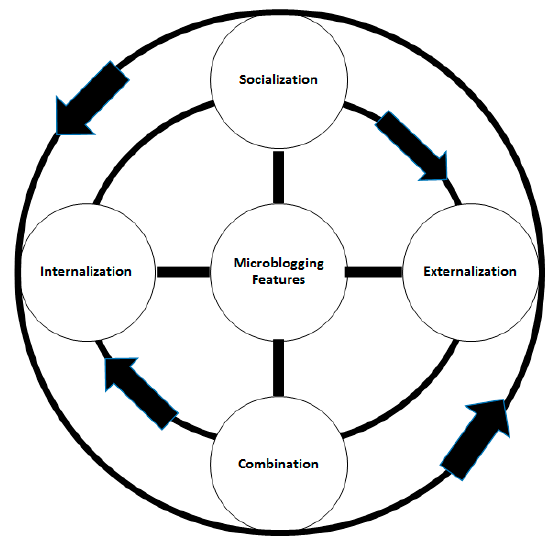
Figure 1. Integration of knowledge creation patterns with SMS microblogging features within shared knowledge domain.